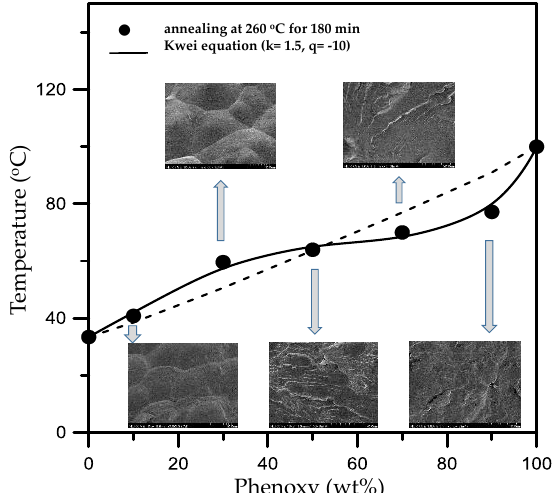
Figure 4. Plots of glass transition temperatures with SEM morphology versus compositions after isothermal treatment at 260 °C for 3 h.